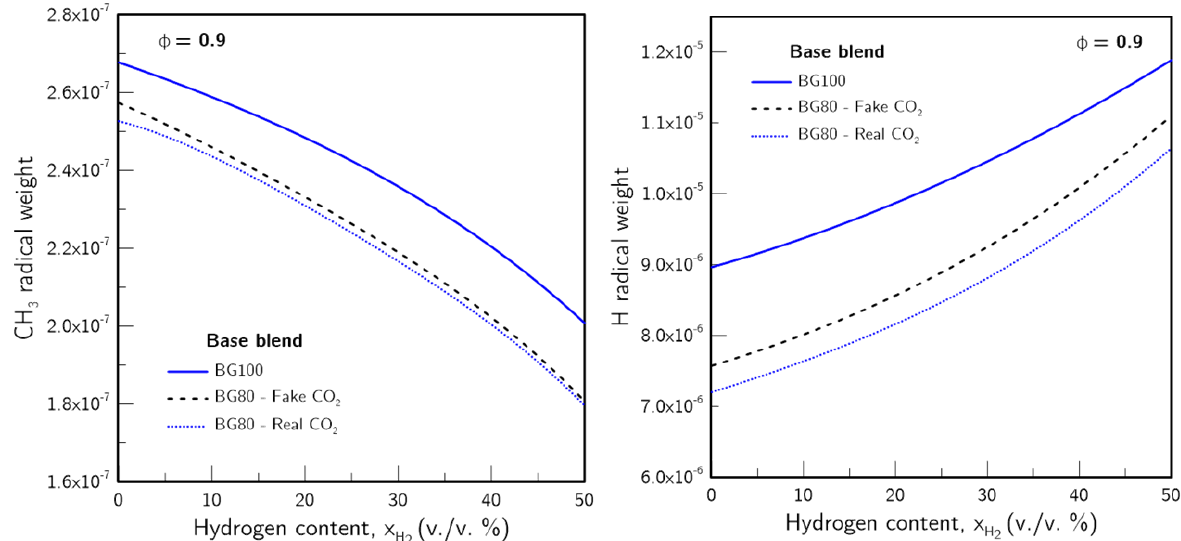
Figure 6. CH and H weight BG100, BG80 and BG80 (FCO 3 Conditions were set at p = 1atm and T u =